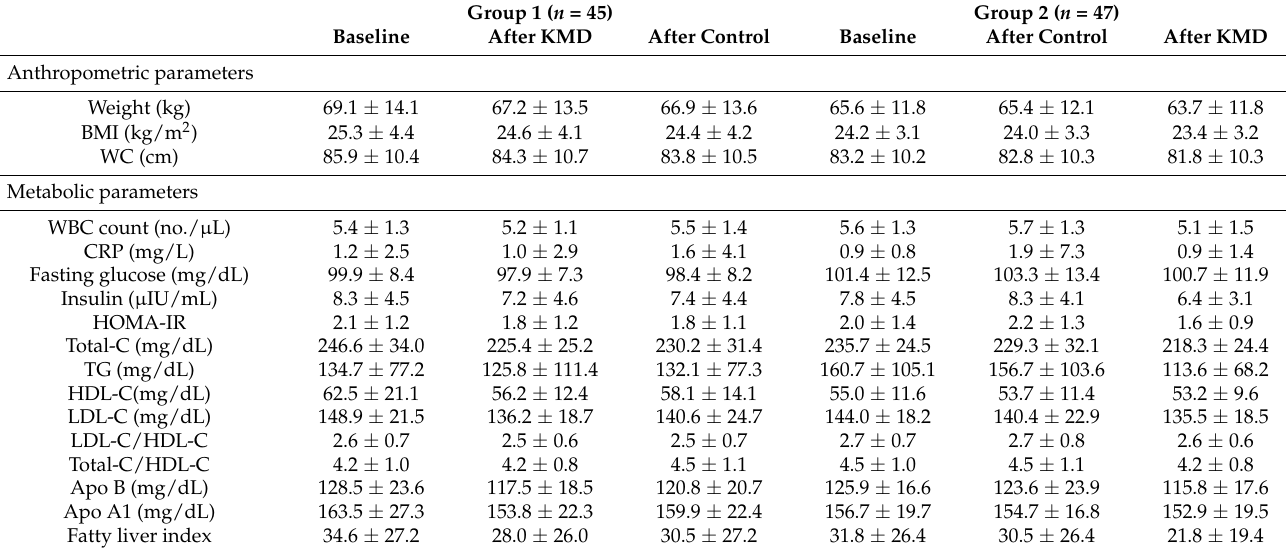
Table A2. Changes of metabolic parameters according to diet type in both